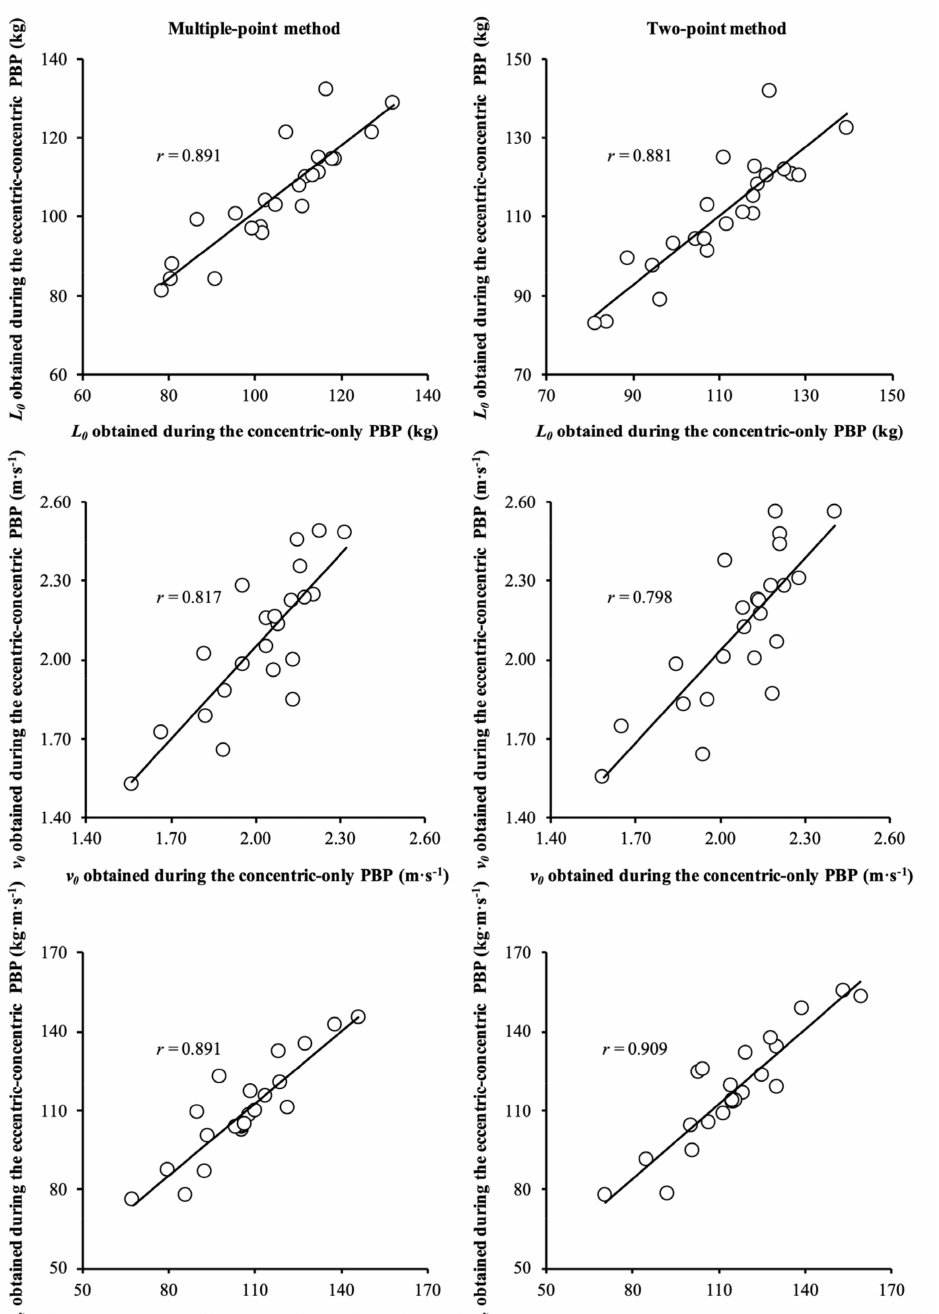
Figure 3. Correlations between the load–velocity relationship variables obtained during the concentric-only and eccentric–concentric prone bench pull (PBP) variants from the multiple-point (left panels) and two-point (right panels) methods. L 0 , load–axis intercept; v 0 , velocity–axis intercept; A line , area under the load–velocity relationship line; r , Pearson’s product-moment correlation